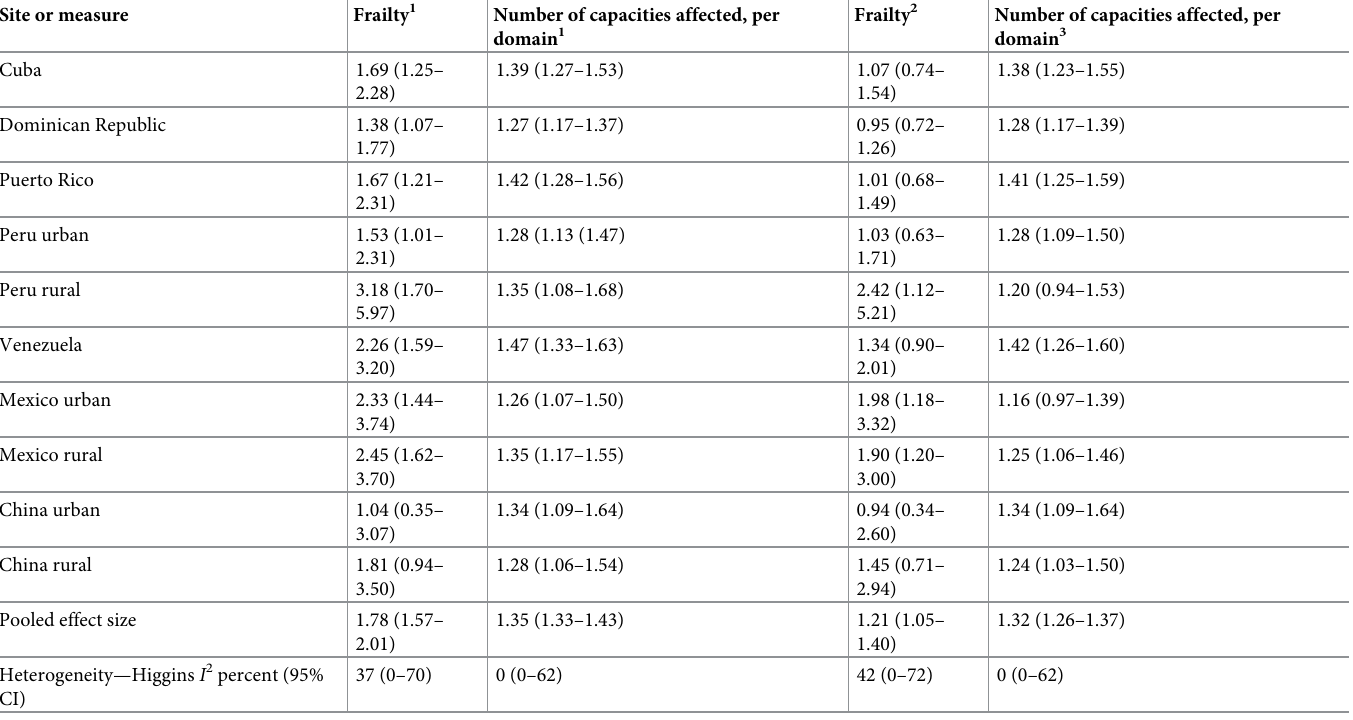
Table 6. The adjusted associations of frailty and declines of intrinsic capacity (number of domains affected, per domain) with incident